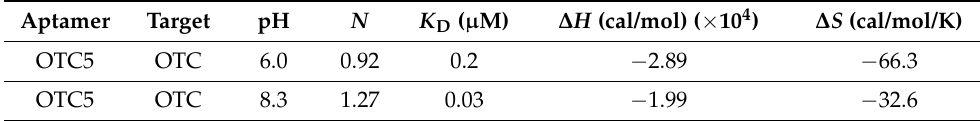
Table 1. Thermodynamic values of the aptamers based on ITC a .